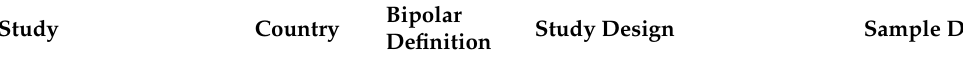
Table 1. Characteristics of Included